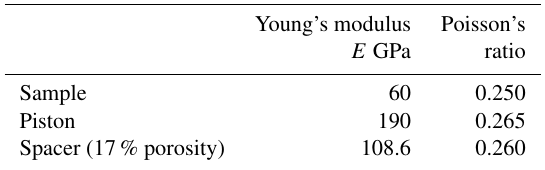
Table 2. Elastic constants of the components in the finite-element models. Young’s modulus Poisson’s E GPa ratio Sample 60 0.250 Piston 190 0.265 Spacer (17% porosity) 108.6